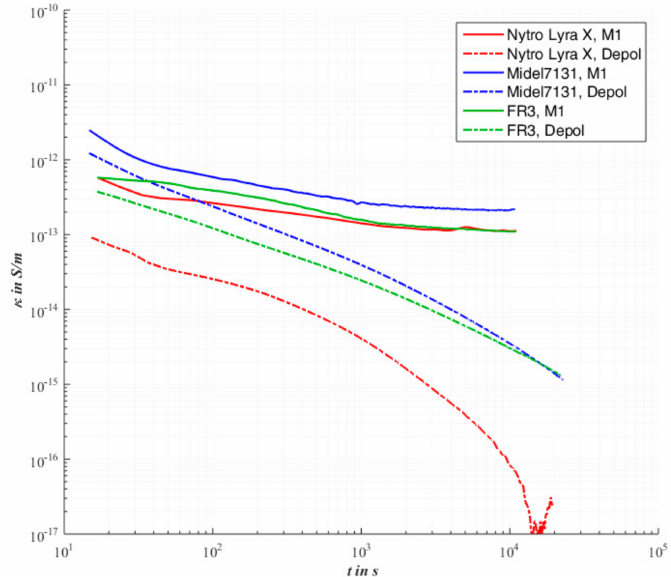
Figure 6. Oil pressboard barrier system